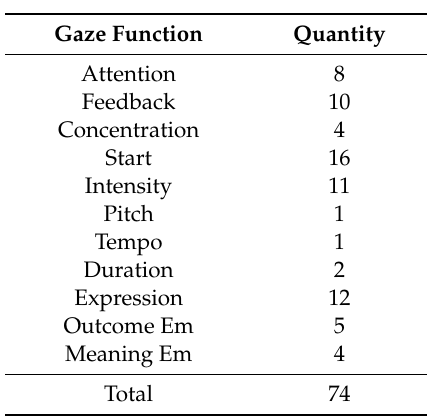
Table 4. Distribution of gaze